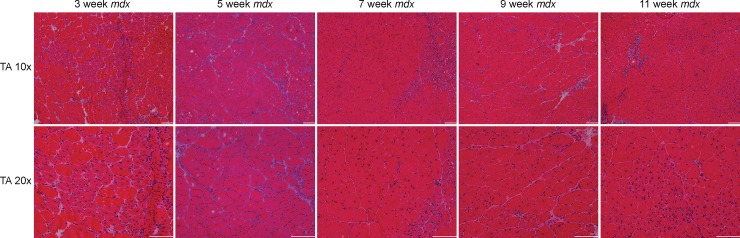
Longitudinal tissue analysis for mdx4cv mice at each timing point (3, 5, 7, 9, and 11 weeks of age) at 10x and 20x magnification.Representative H&E histology images of the TA muscle in mdx4cv mice. Images are taken from the same area of muscle for both 10x and 20x images (scale bar represents 100 μm).